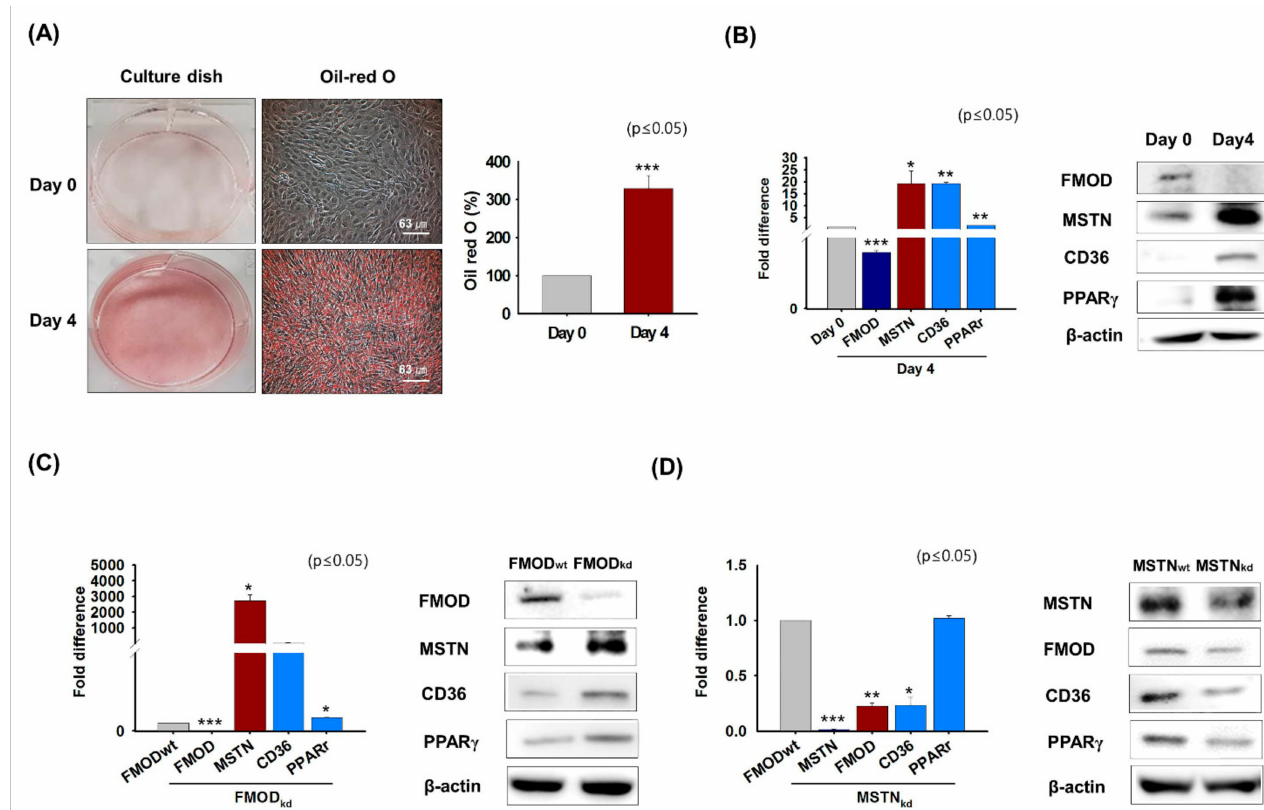
Figure 5. FMOD and MSTN expressions under adipogenic conditions. C2C12 cells were incubated in adipogenic media for 4 days. ( A ) Oil-red O staining was performed and intensities were measured at day 0 and after culture for 4 days. ( B ) mRNA and protein expressions of FMOD, MSTN, CD36, and PPAR γ were determined by real-time RT-PCR and Western blot, respectively. ( C , D ) FMOD and MSTN were knocked down and cells were incubated in adipogenic media for 4 days . mRNA and protein levels of FMOD, MSTN, CD36, and PPAR were determined by real-time RT-PCR and Western blot, respectively. FMOD wt and MSTN wt indicate cells transfected with scrambled vector. Means ± SD (n > 3). * p ≤ 0.05, ** p ≤ 0.001, *** p ≤